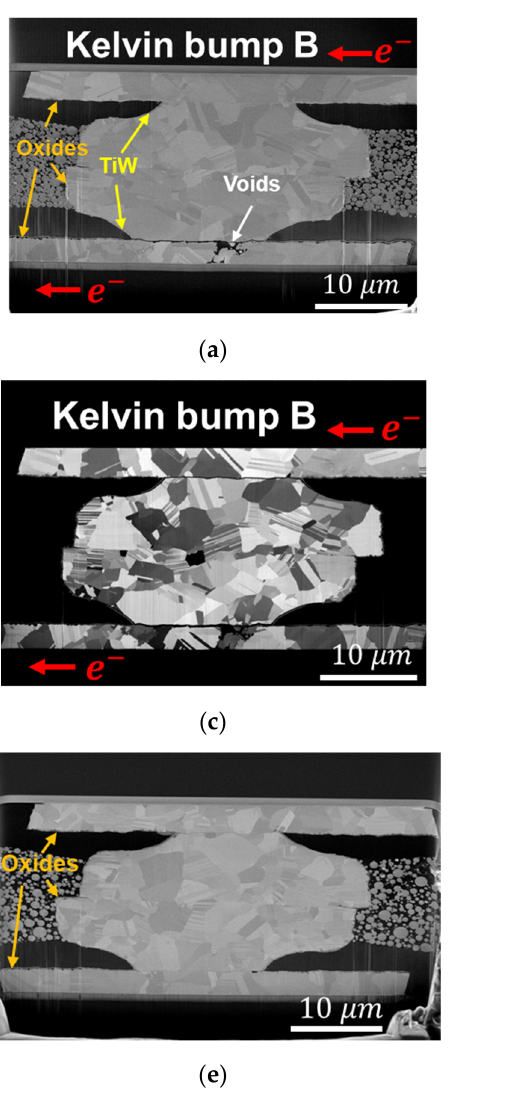
Figure 7. Destructive observation of 90 MPa/30 s_K3 bumps. ( a , b ) Electron images of Kelvin bumps B and A, respectively. Voids are located at the top die RDL of Kelvin bump A and the bottom die RDL of Kelvin bump B, which is the same as the nondestructive observation results. The voids at the lower part of Cu–Cu bump A can be seen in ( b ). The voids form at the side of electron current passing through the TiW layer. ( c , d ) Ion images of Kelvin bumps B and A, respectively. The voids caused by the EM are along the grain boundary and TiW layer at the PSV opening. ( e , f ) Electron image and ion image of dummy bumps, respectively. Copper oxide can be found at the surface of Cu–Cu bumps and RDLs.